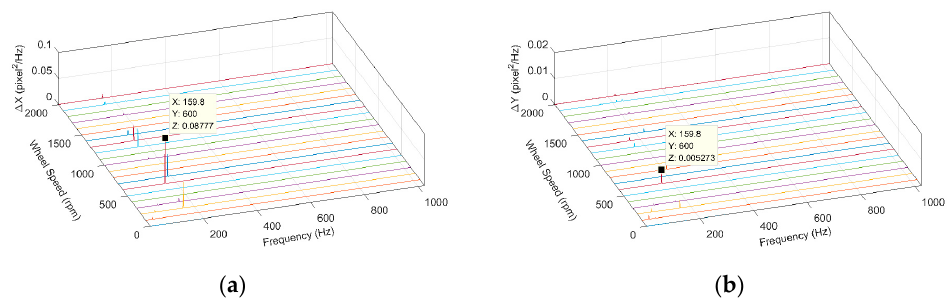
Figure 10. The waterfall of image motion. ( a ) x-direction; ( b ) y-direction. The FRF and coherence function at 600 rpm are shown in Figure 11. For simplicity, only H 16 and H 26 are shown. The figure shows that the coherence at 159.5 Hz is roughly equivalent to 0.8, demonstrating the dependability of the FRF at this frequency.